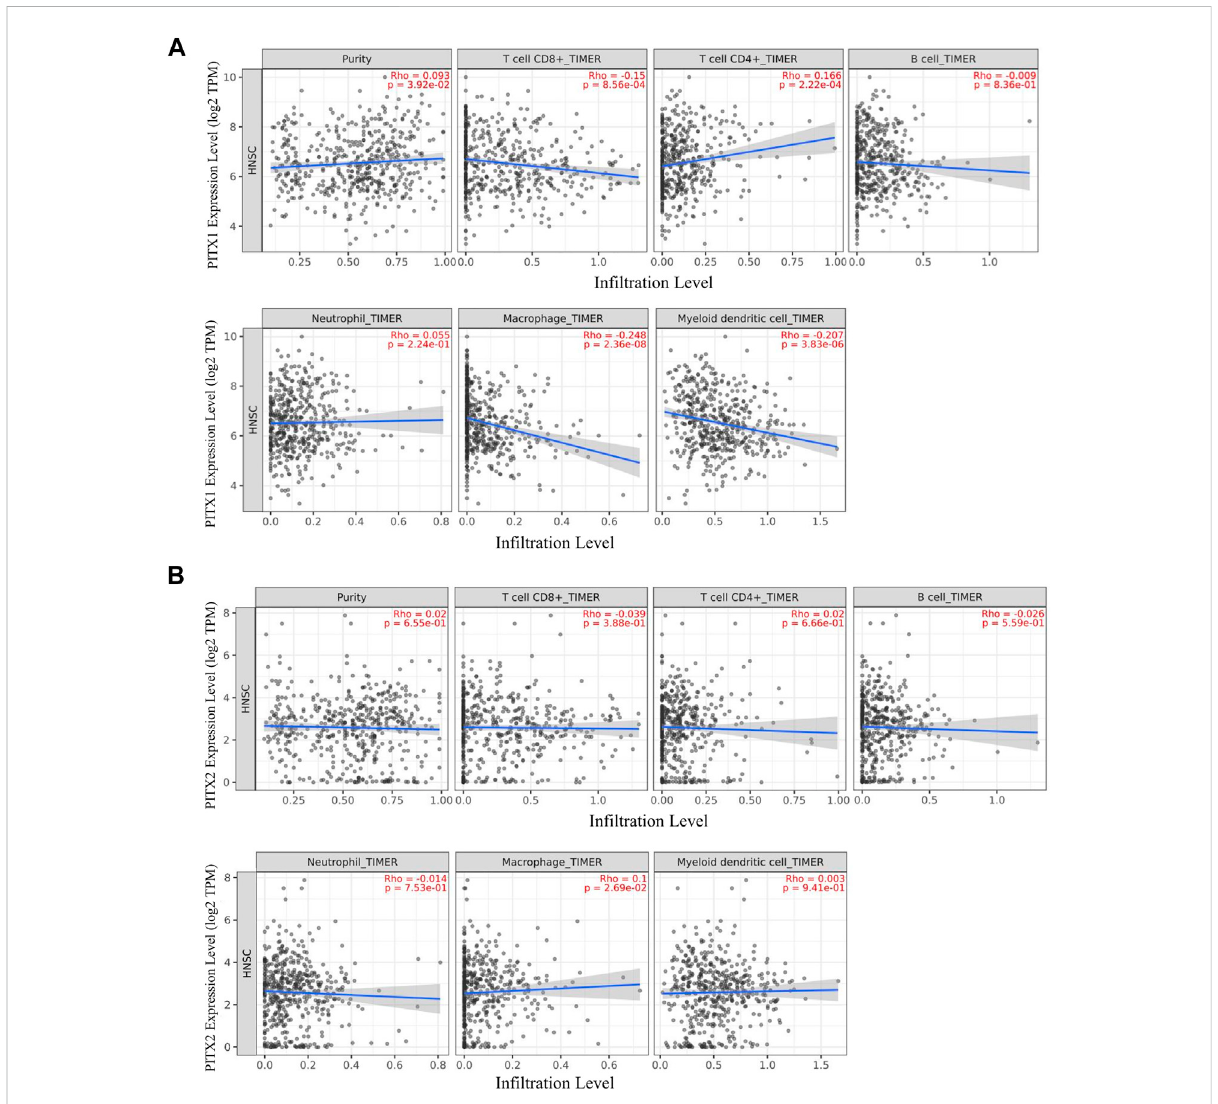
FIGURE 7 TIMER analysis of correlations between PITX1 and PITX2 expression and immune cell in fi ltration in HNSC. (A) Correlations between PITX1 expression and immune cell in fi ltration were evaluated using TIMER. (B) Correlation between PITX2 expression and immune cell in fi ltration levels using